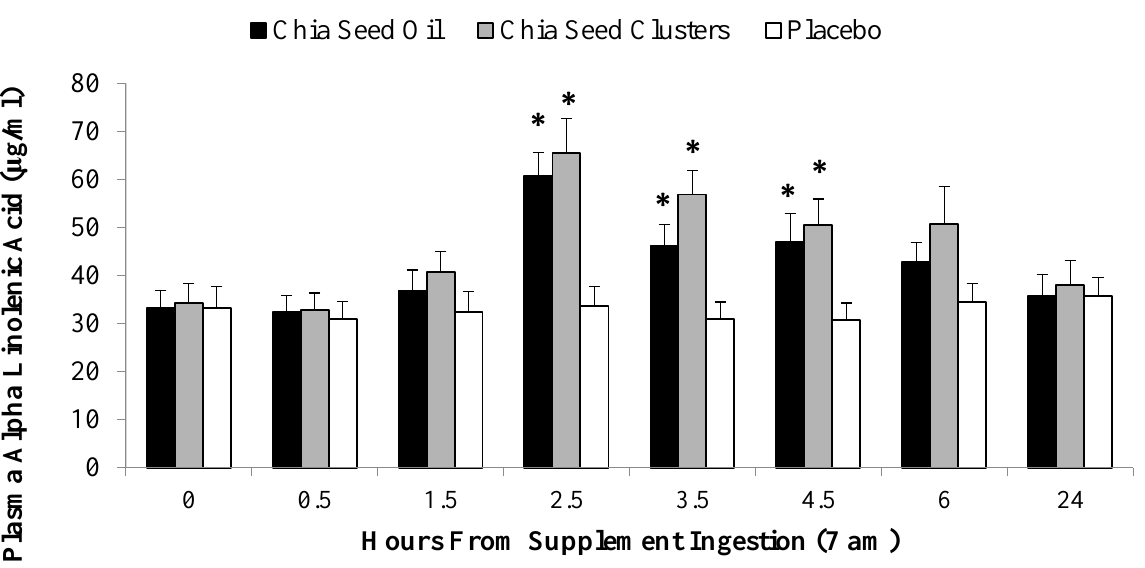
Figure 1. Change in α-linolenic acid (ALA) over time after ingestion of 1.3 mg ALA from milled chia seeds in a snack cluster and chia seed oil (CSO), compared to placebo. * p < 0.025, change from pre-supplementation, relative to